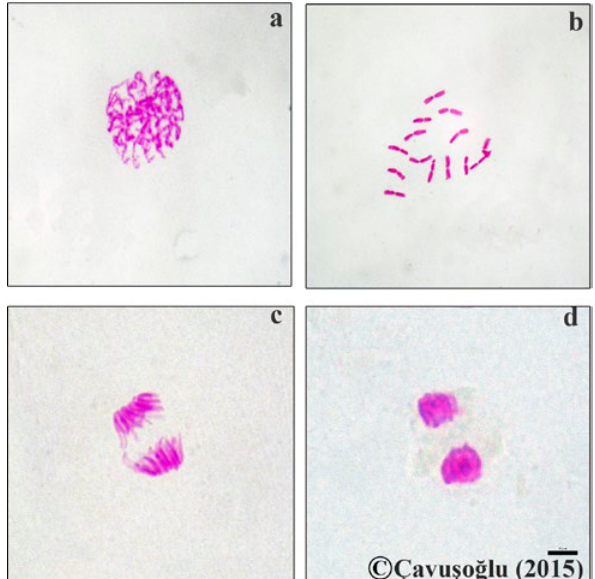
Fig. 1. Normal mitosis phases in root tips meristems of barley ger- minated in distilled water (control). (a) Prophase; (b) metaphase (2 n = 14); (c) anaphase; (d) telophase. Scale bar =